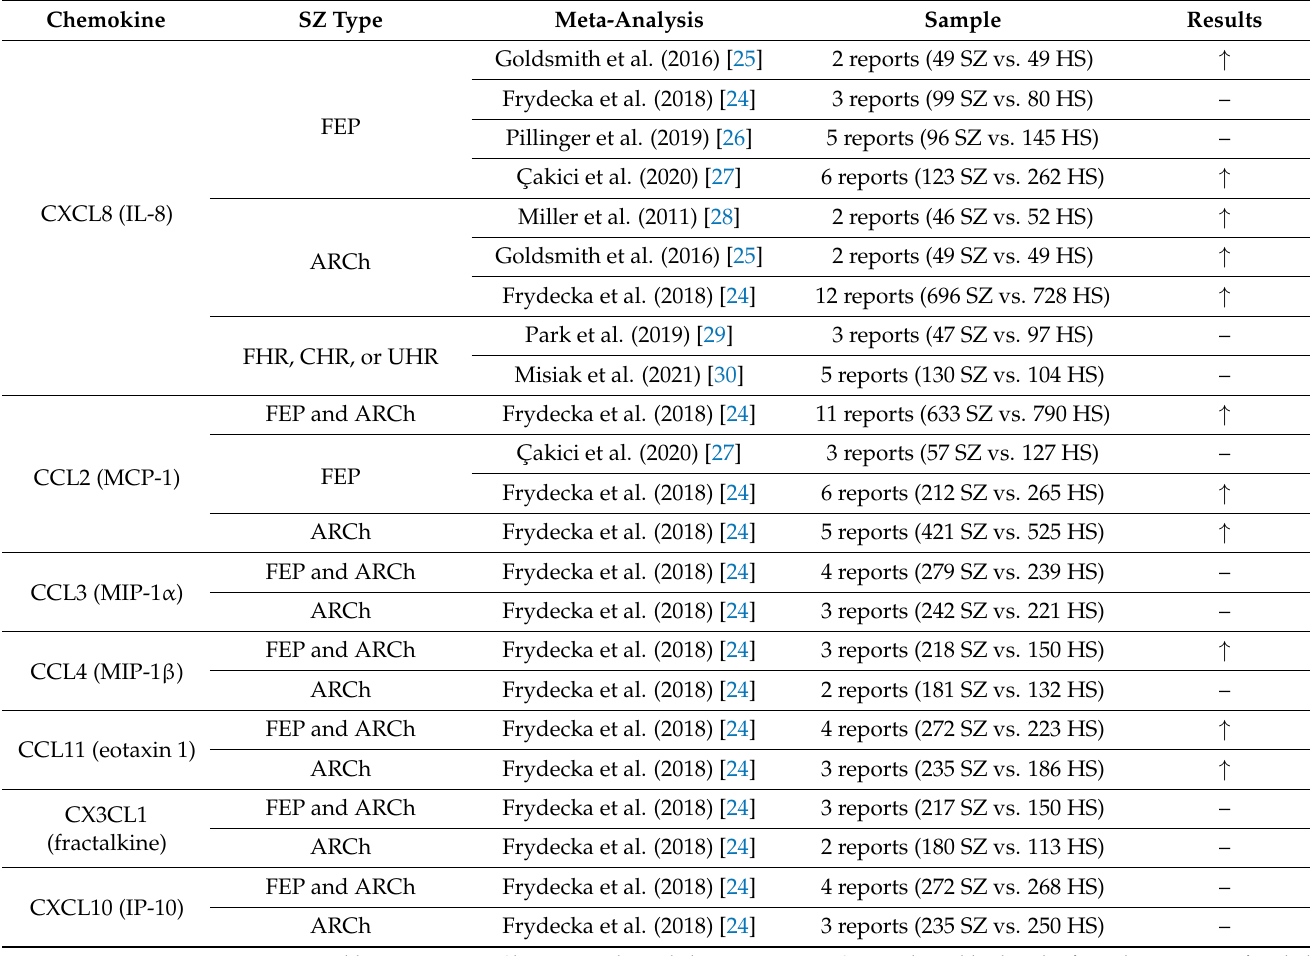
Table 2. Meta-analytic data on blood levels of chemokines in patients with SZ compared with healthy